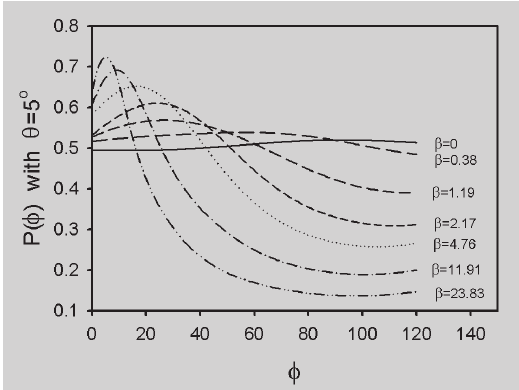
Figure 4: Evolution of the form factor, P( q , f ), with the angle f for fix f = 5˚ and varying b